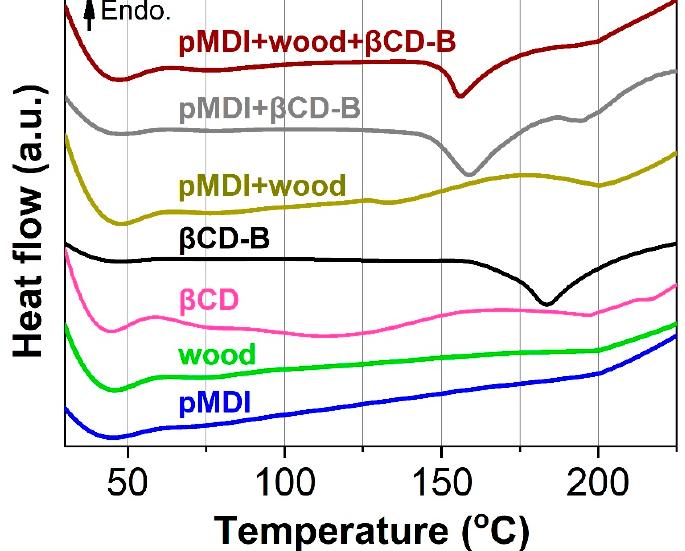
Figure 5. Di ff erential scanning caliometry (DSC) curves of pMDI resin, β CD–B complex, wood and their physical mixture.